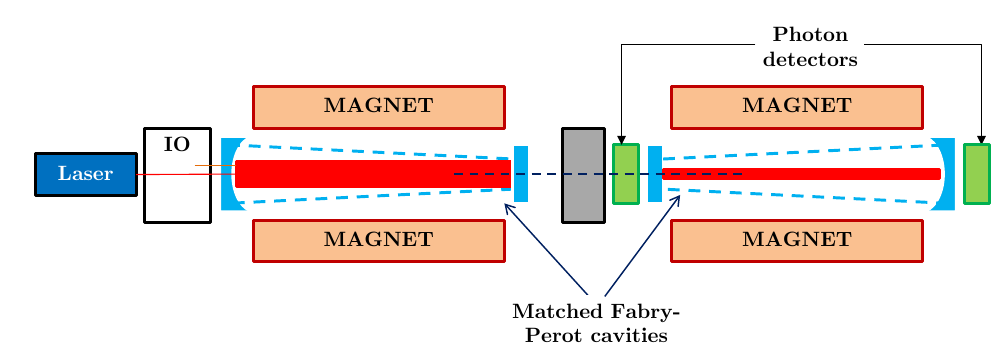
Figure 4: The principle of photon regeneration. The laser on the left injects a large number of photons to the production region. Some of them convert into axions that traverse the opaque wall in the middle into the regeneration region on the